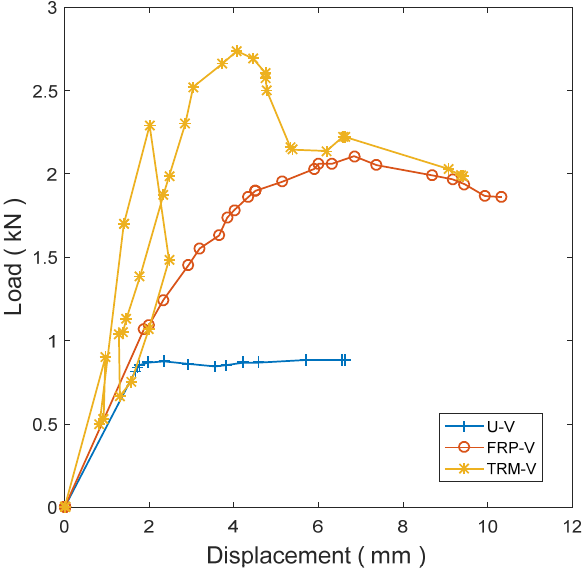
Figure 30. A comparison between unreinforced (U-V) and reinforced (FRP-V and TRCM-V) vaults: Load-displacement curves [130].